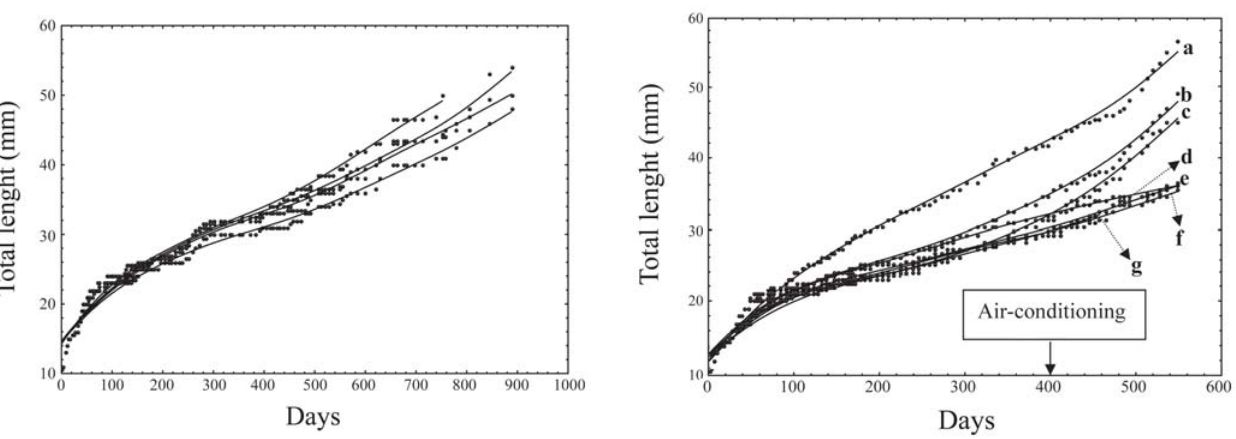
Fig. 2. Size (total length, in mm) versus age (in days) in four specimens of Ancistrus cryptophthalmus from Passa Três Cave born in laboratory in March 2003.